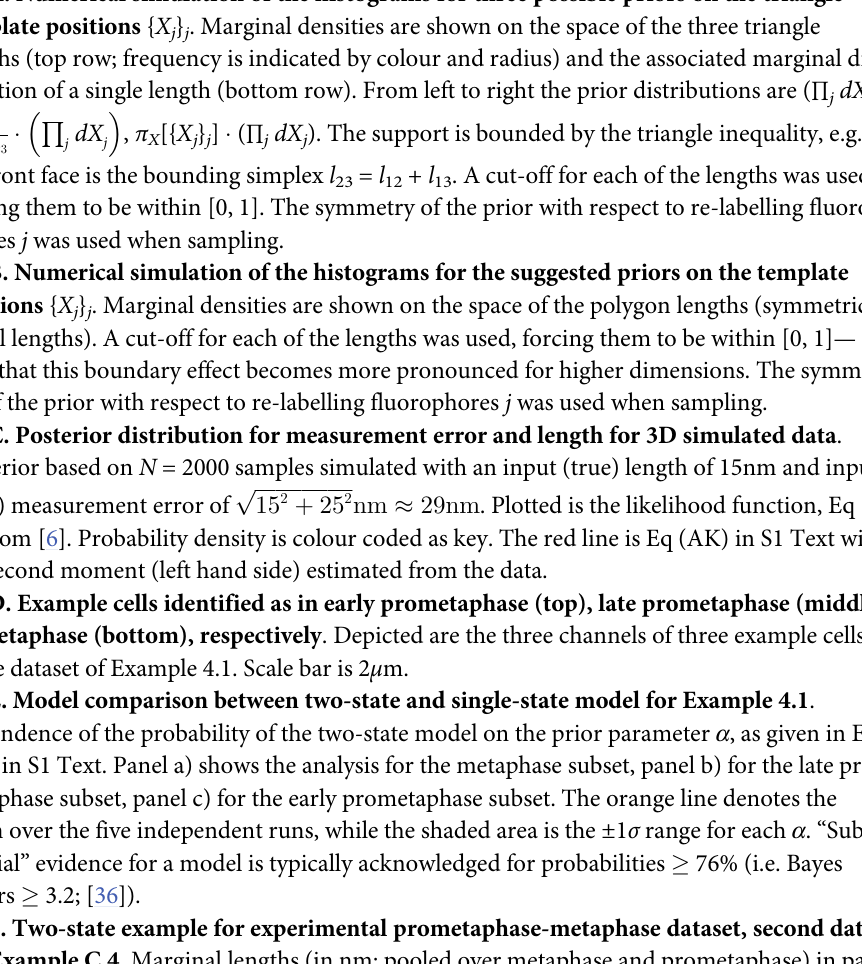
Fig A. Numerical simulation of the histograms for three possible priors on the triangle template positions { X } . Marginal densities are shown on the space of the three triangle j j lengths (top row; frequency is indicated by colour and radius) and the associated marginal dis- tribution of a single length (bottom row). From left to right the prior distributions are ( ∏ ), dX j j � � Q 1 , π � [{ X } ] � ( ∏ ). The support is bounded by the triangle inequality, e.g. dX dX X j j j j j j l 12 � l 13 � l 23 the front face is the bounding simplex l = l + l . A cut-off for each of the lengths was used, 23 12 13 forcing them to be within [0, 1]. The symmetry of the prior with respect to re-labelling fluoro- phores j was used when sampling. Fig B. Numerical simulation of the histograms for the suggested priors on the template positions { X } . Marginal densities are shown on the space of the polygon lengths (symmetric j j for all lengths). A cut-off for each of the lengths was used, forcing them to be within [0, 1]— note that this boundary effect becomes more pronounced for higher dimensions. The symme- try of the prior with respect to re-labelling fluorophores j was used when sampling. Fig C. Posterior distribution for measurement error and length for 3D simulated data . Posterior based on N = 2000 samples simulated with an input (true) length of 15nm and input ffiffiffiffiffiffiffiffiffiffiffiffiffiffiffiffiffiffiffi p (true) measurement error of 15 2 þ 25 2 nm � 29nm . Plotted is the likelihood function, Eq (6) from [6]. Probability density is colour coded as key. The red line is Eq (AK) in S1 Text with the second moment (left hand side) estimated from the data. Fig D. Example cells identified as in early prometaphase (top), late prometaphase (middle) or metaphase (bottom), respectively . Depicted are the three channels of three example cells of the dataset of Example 4.1. Scale bar is 2 μ m. Fig E. Model comparison between two-state and single-state model for Example 4.1 . Dependence of the probability of the two-state model on the prior parameter α , as given in Eq (AP) in S1 Text. Panel a) shows the analysis for the metaphase subset, panel b) for the late pro- metaphase subset, panel c) for the early prometaphase subset. The orange line denotes the mean over the five independent runs, while the shaded area is the ± 1 σ range for each α . “Sub- stantial” evidence for a model is typically acknowledged for probabilities � 76% (i.e. Bayes factors � 3.2; [36]). Fig F. Two-state example for experimental prometaphase-metaphase dataset, second data- set, Example C.4 . Marginal lengths (in nm; pooled over metaphase and prometaphase) in pan- els a)–d), the majority state in metaphase is depicted in red, the minority state in green. See supplement Uninformative priors in S1 Text for the joint prior on the lengths. Marginals of the internal angles of the two states are shown in panels e), f). The marginal state proportions of the metaphase-minority state is depicted for each mitotic phase in panel g). The prior on each state proportion is flat in [0, 1]. The mean state affiliations f � z n g for each mitotic phase is n shown in panel h), exhibiting clearly separated preferences for kinetochores in metaphase and early prometaphase, while late prometaphase contains some kinetochores that are likely attached, some likely unattached and some undecided. The shown mean state affiliations are with respect to the natural unattached state, i.e. kinetochores with a value close to one would be most likely in jthe natural unattached state. The bottom row compares the inferred mean state affiliations of each kinetochore with the tension parameters: Panel i) shows the mean sis- ter-sister distance l , panel j) the mean swivel ϑ , where the mitotic phase is colour-coded and ss the straight lines show the best fit linear model for each phase. For significance tests, see Table K in S1 Text. Fig G. Comparison of lengths marginals of jack-knifed (nocodazole), naturally unattached and attached states of CenpC–Ndc80C–Ndc80N triangle . Shown are the length marginals of the CenpC–Ndc80C–Ndc80N triangle in the three conformational states inferred in this study (attached, naturally unattached and jack-knifed), combining results of Examples 3.2, 3.3,